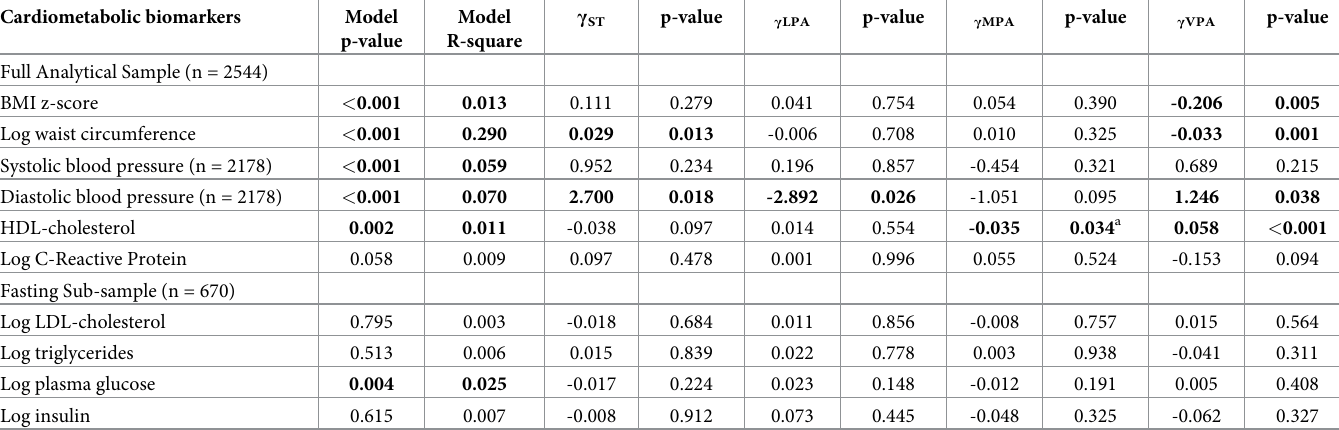
Table 4. Compositional linear regression for the associations between ST, LPA, MPA, and VPA and cardiometabolic biomarkers. Cardiometabolic